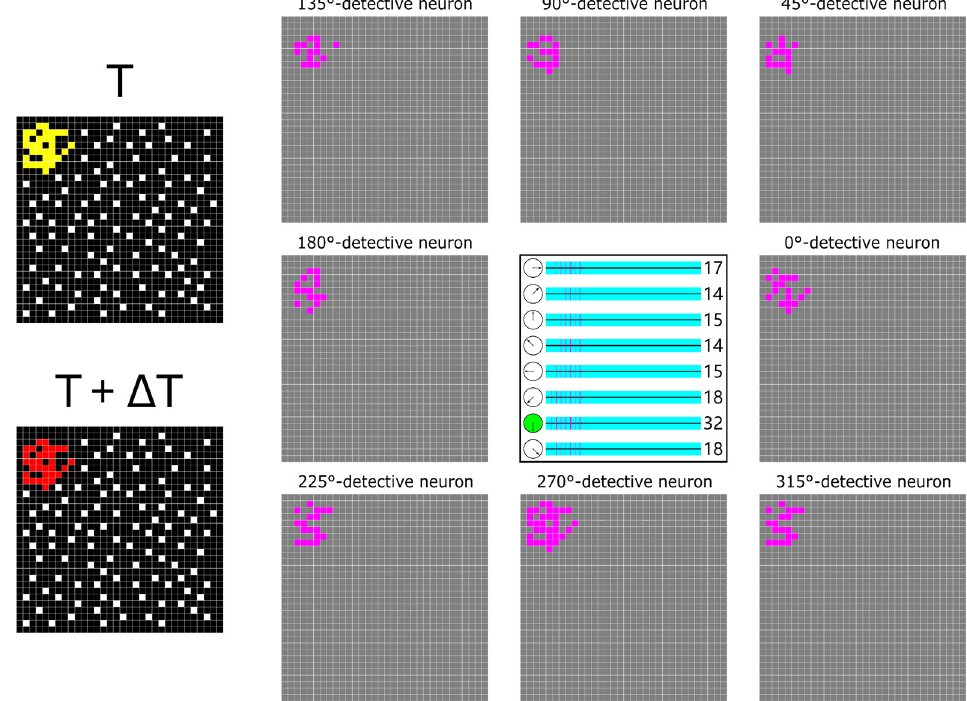
Table 2. Detection results of the AVS within the background with separated noises.